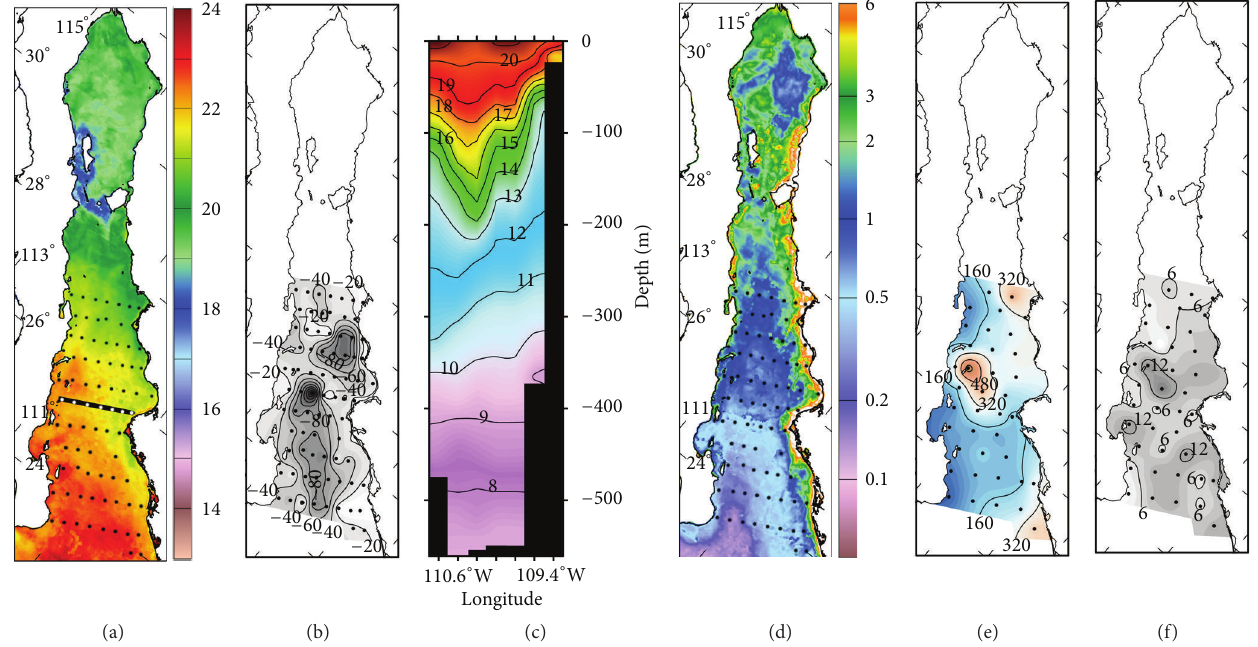
Figure3:BiophysicalcharacteristicsduringMarch.Compositeof(a)SST( ∘ C)and(d)CHL(mgm −3 )satelliteimagesoftheGulfofCalifornia. Blacklinein(a)indicatestransectanalyzedforwatercolumnprofile.(c)Temperatureprofile( ∘ C).Distributionof(b)maximumstabilitydepth (MSD), (e) zooplankton volumes, and (f) species